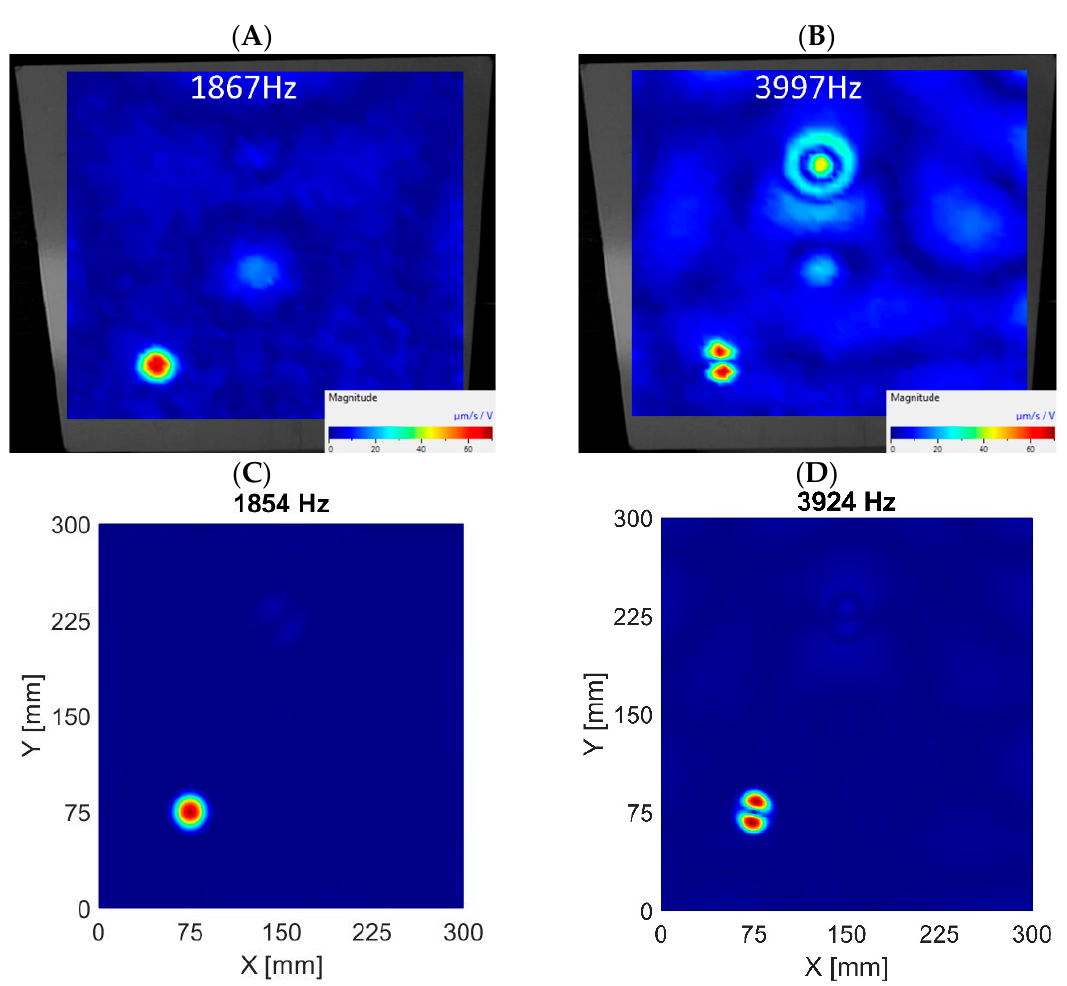
Figure 10. Visualization of out-of-plane vibrations—FBH Ø40 mm. The first LDR in experimental data ( A ) and numerical results based on the 3D FE model ( C ). The second LDR in experimental data ( B ) and numerical results based on the 3D FE model ( D ).